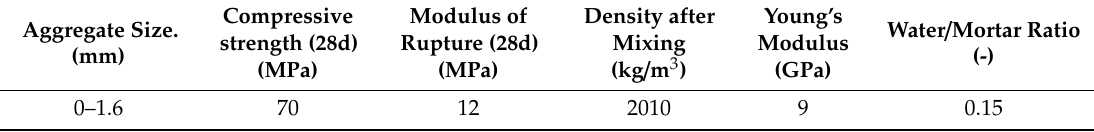
Table 2. Properties of the cementitious matrix, based on